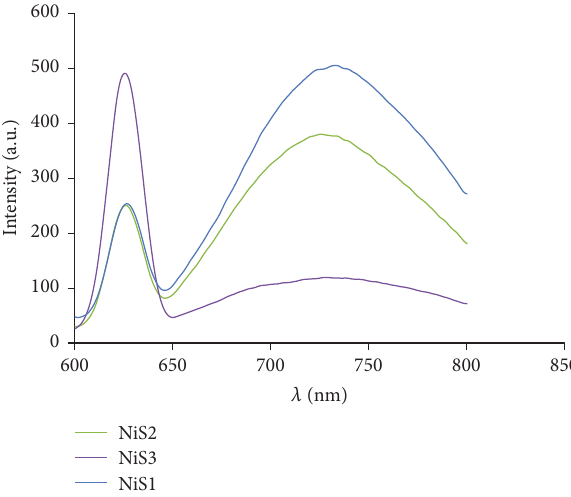
Figure 3: Absorption spectra of HDA-capped NiS nanoparticles.